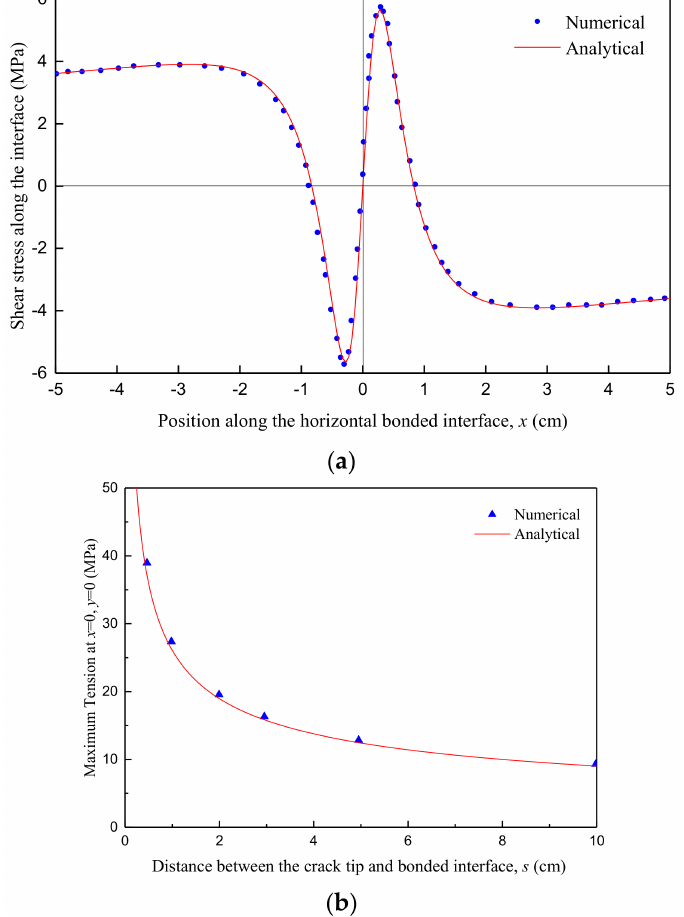
Figure 7. Comparison of the analytical solution of the stresses with numerical results. ( a ) Shear stress when gap is 0.5 cm; ( b ) Maximum tension under different